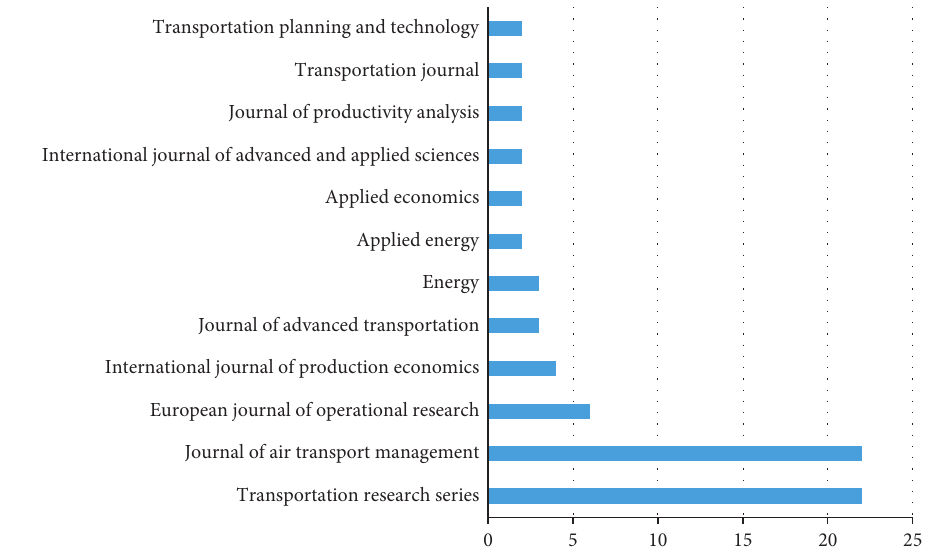
Figure 1: Distribution of publication among main journals. Table 1: Application of standard DEA in airline